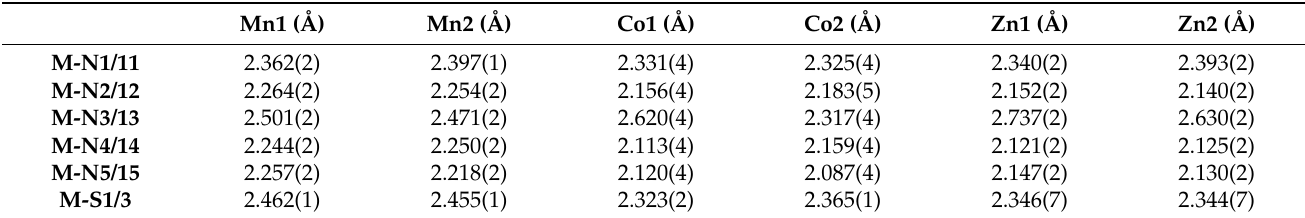
Table 2. Metal to donor bond lengths for [Mn1H L ] + , [Mn2H L ] + , [Co1H L ] + , [Co2H L ] + , [Zn1H L ] + and [Zn2H L ] +